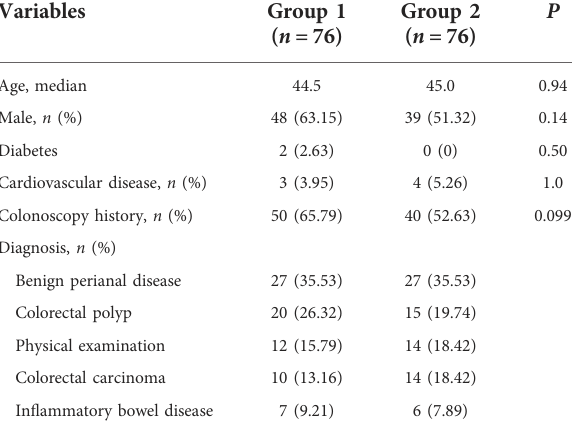
TABLE 1 Comparison of the demographic and clinical characteristics of two